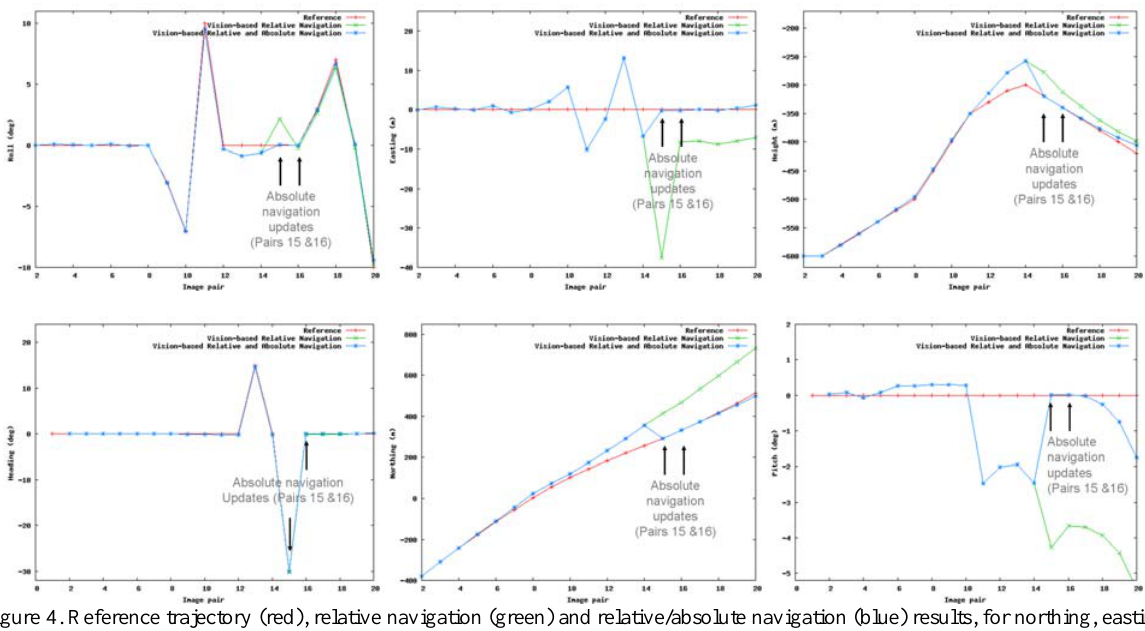
Figure 4. Reference trajectory (red), relative navigation (green) and relative/absolute navigation (blue) results, for northing, easting, height (in meters), and heading, pitch and roll (in degrees), left to right, top to bottom. Preliminary results for relative and absolute